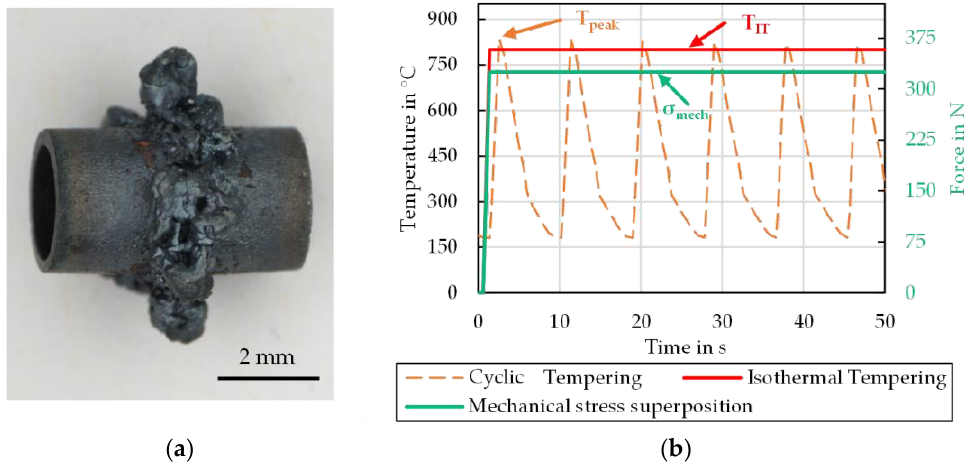
Figure 4. ( a ) Collapsed specimen after 15 cycles at 900 °C peak temperature testing, ( b ) Time-tem- perature loading profiles for the cyclic and isothermal tempering tests. Table 4. Test parameters for the isothermal tempering tests with mechanical stress superposition. Table 3. Test parameters for the cyclic thermo-mechanical tempering